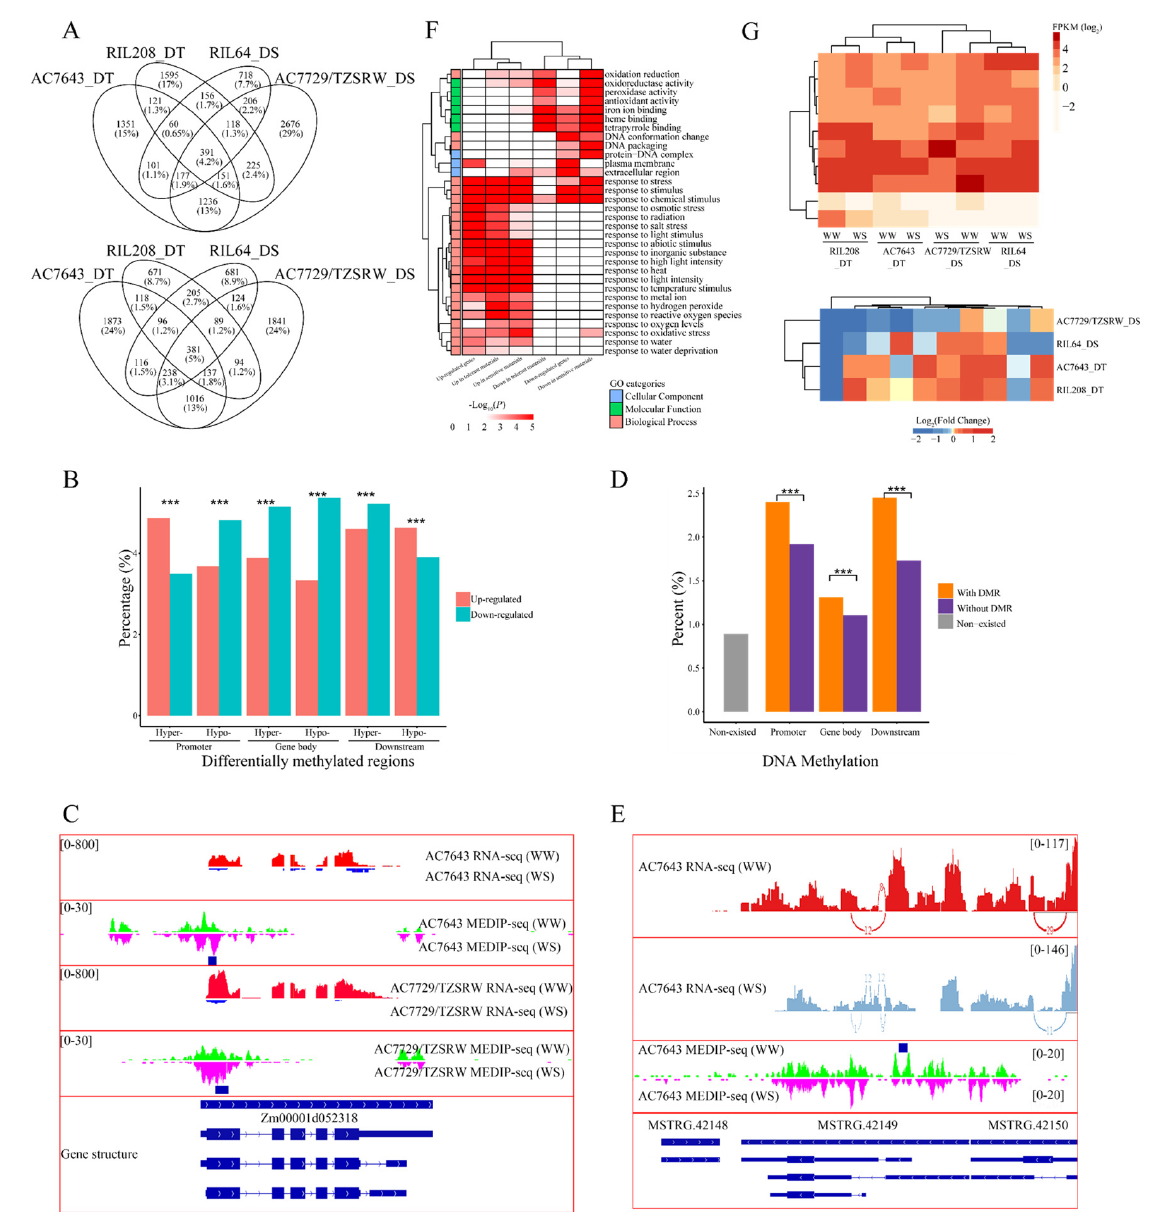
Figure 5. DNA methylation involved in gene response under WS. ( A ) Venn diagram comparing up-regulated genes (upper) and down-regulated genes (bottom) in four inbred lines. ( B ) The proportion of up-regulation and down-regulation genes with different DNA methylation response in the promoter, the gene body and downstream. ***: p < 0.001, χ 2 test. ( C ) Examples of genes with hyper-methylated in the gene body and decreased expression under WS. ( D ) The proportion of genes with DAS under water stress. ***: p < 0.001, χ 2 test. ( E ) Examples of genes hyper-methylated in the gene body and differential AS pattern under WS. ( F ) GO enrichment of differentially expressed genes (DEGs). Only GO terms with FDR < 0.001 in at least two groups were plotted. ( G ) The clustered heatmap of expression (upper) and fold change (bottom) under WS of genes which was association with DMRs and classified in “gene silencing by RNA” GO term.